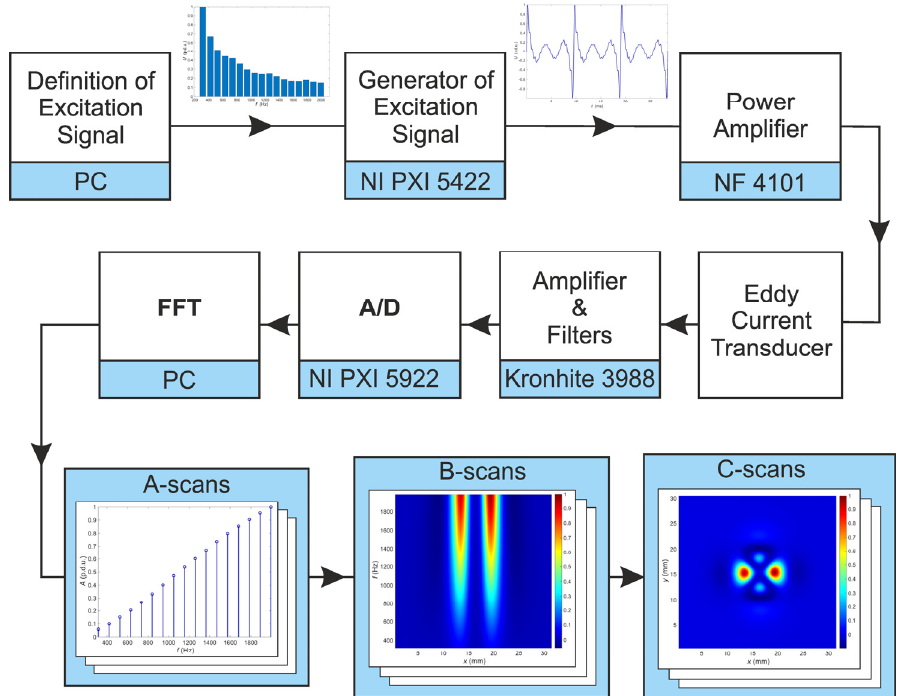
Figure 5. The block scheme of the MMFES system.